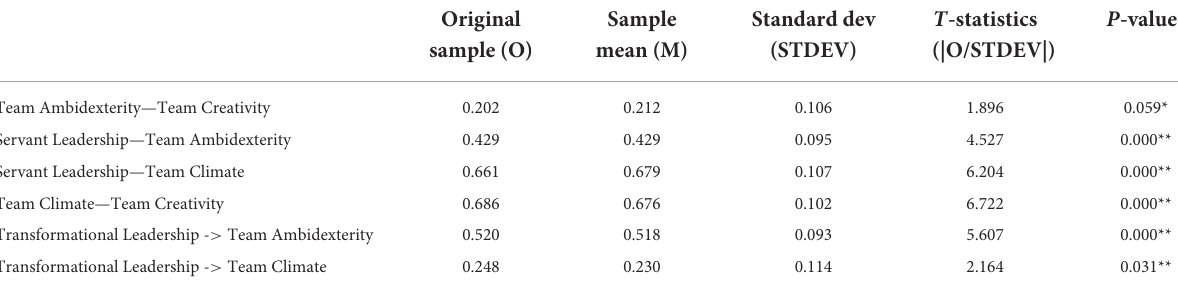
TABLE 8 Path coefficient and t -statistic.